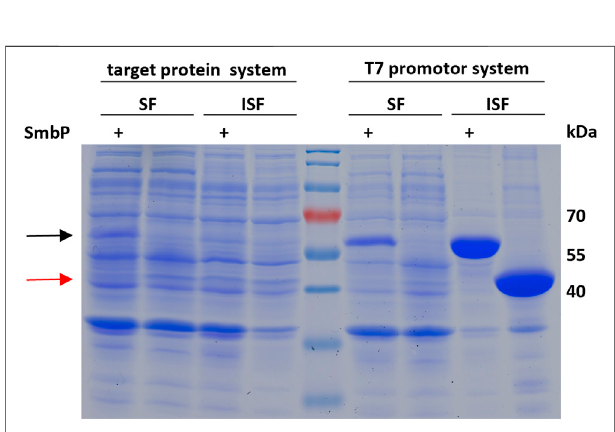
FIGURE 7 | SDS-PAGE analysis of the soluble (SF) and insoluble (ISF) protein fractions of whole cell lysates. Left half: aaRS co-expression setup (driven by lpp promotor) as used for ncAA incorporation. Right half: aaRS overproduction setup driven by the strong T7 promoter. Calculated molecular weights: SmbP- Mb SacRS (cid:1) 57.5 kDa (black arrow), Mb SacRS (cid:1) 47.6 kDa (red arrow).